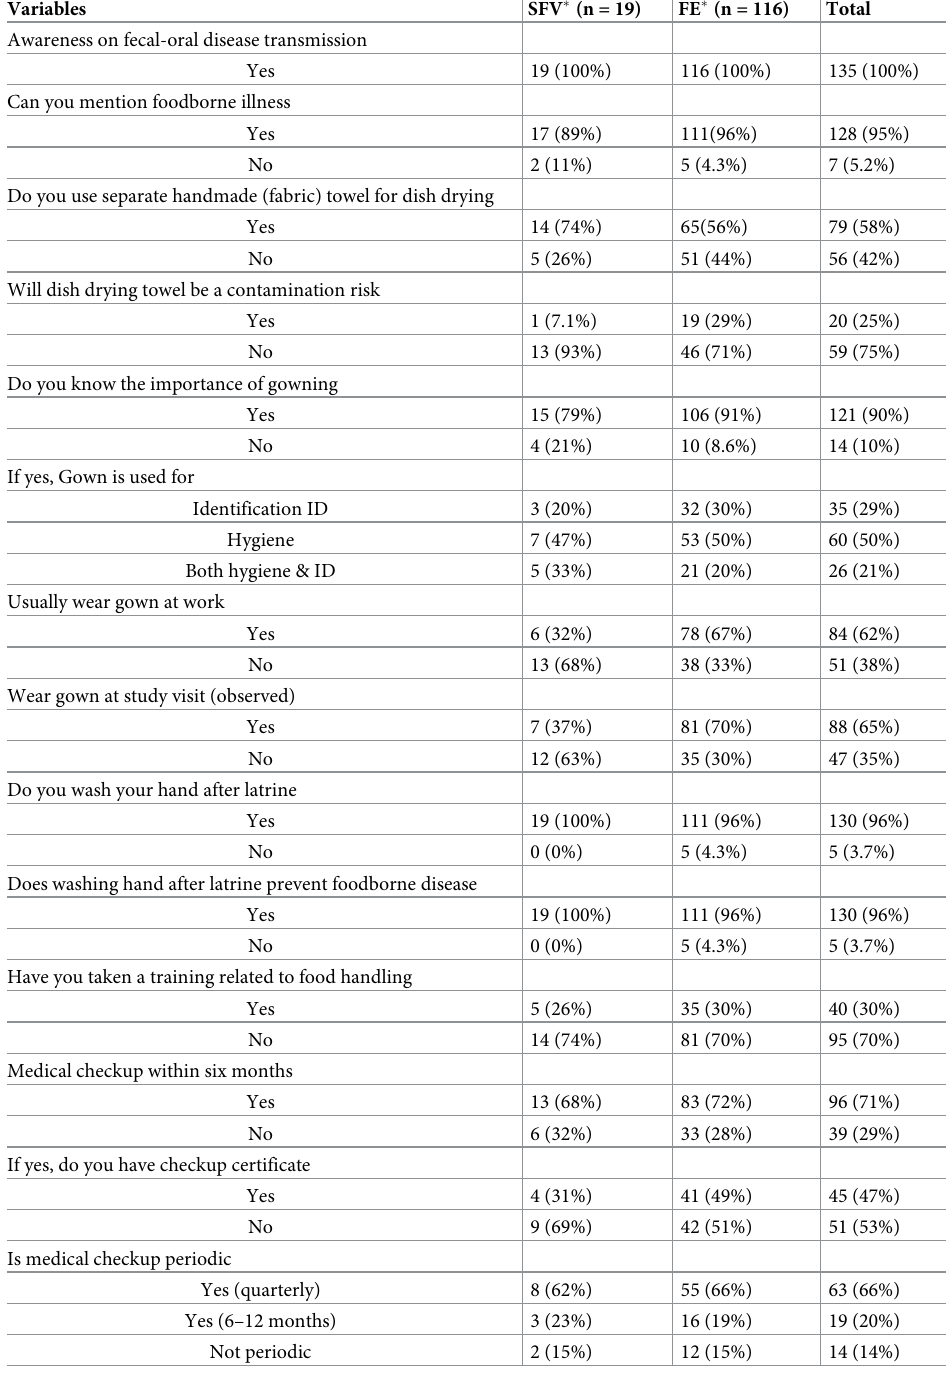
Table 3. Comparison of measures of food hygiene and safety among street food vendors and food handlers in food establishments from December 2013 to June 2014, Dessie town, Ethiopia. Variables SFV (cid:3) (n =